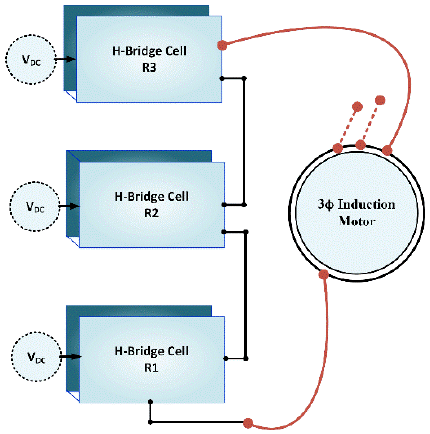
Figure 2. Simulink model of 1-Φ cascaded H-Bridge 5-level inverter fed with Induction Motor load.